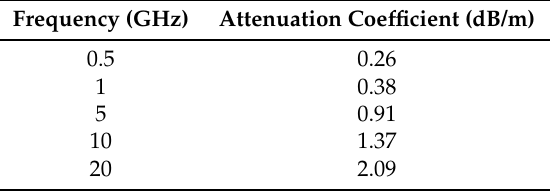
Table 3. UT141 typical attenuation.